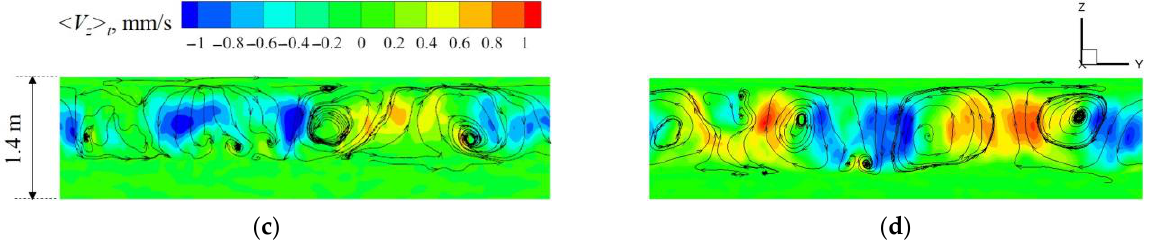
Figure 4. ( a , b ) Isosurfaces of the time-averaged vertical velocity component (| V z | = 0.5 mm/s, red structures correspond to ascending currents, blue structures correspond to descending currents); ( c , d ) the fields of the time-averaged vertical velocity component in the central vertical section, Variant 2; ( a , c ) 4th day, 3 p.m., ( b , d ) 5th day, 3 p.m. X, Y—horizontal coordinates, Z—vertical coordinate.